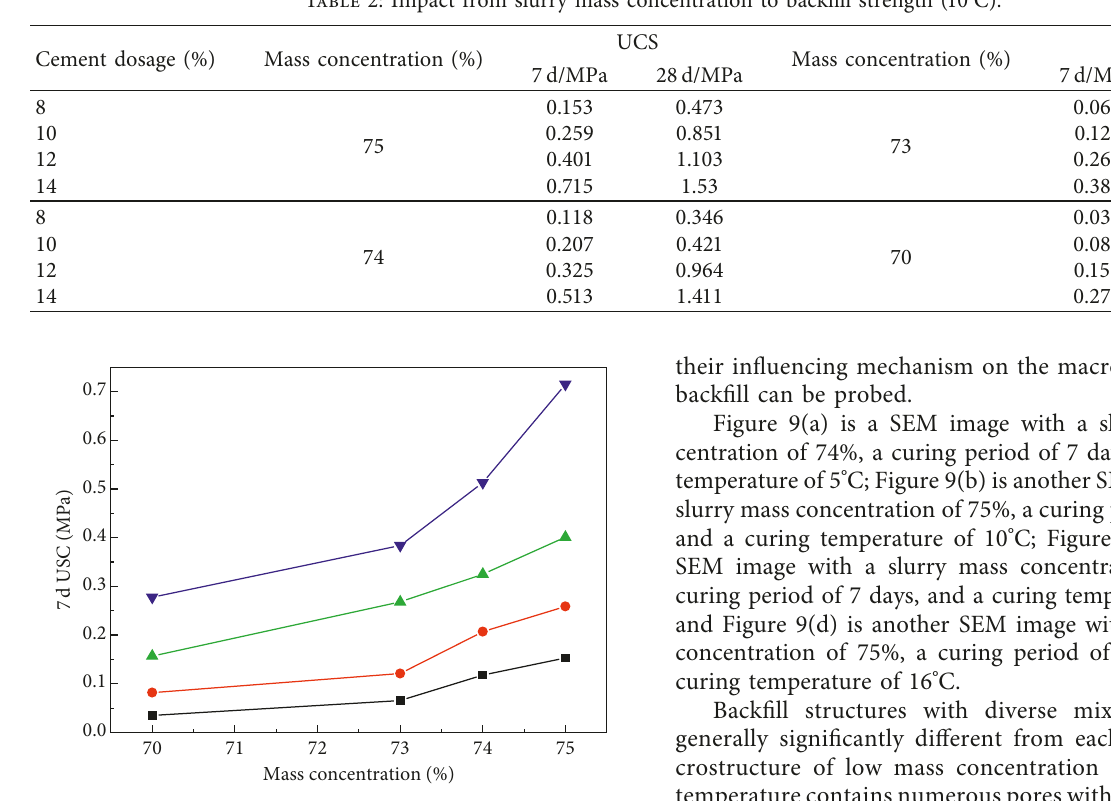
Table 2: Impact from slurry mass concentration to backfill strength (10 ° C).